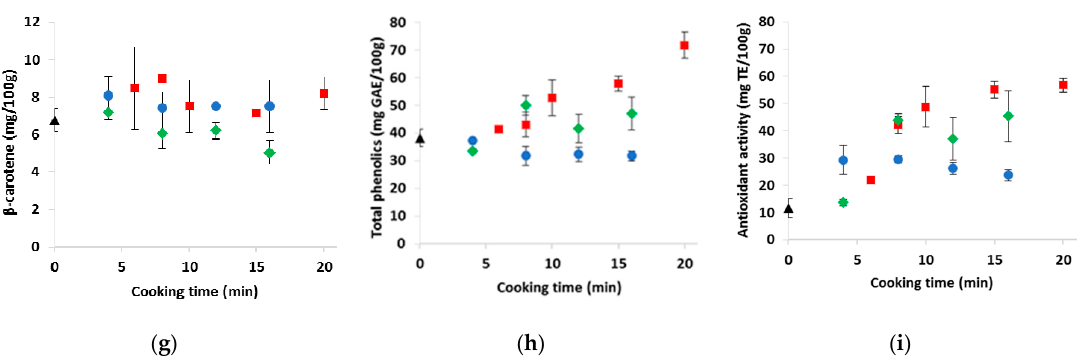
Figure 2. Nutritional properties of the ( a – c ) cauliflowers, ( d – f ) carrots and ( g – i ) sweet potatoes cooked by the different cooking systems and times. Data are averaged per trial and standard deviation bars are shown. GAE, Gallic acid equivalent; TE, Trolox equivalent; black triangle, raw samples; blue point, boiled samples; green diamond, steamed samples; red square, microwaved samples.